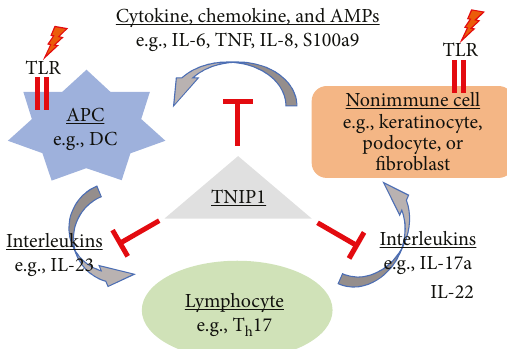
Figure 2: IL-23/Th17 axis of psoriasis. Proposed paracrine signaling with TNIP1 regulation in psoriasis where nonimmune cells are keratinocytes [111]. We would suggest that variations of this could be relevant for SLE and SSc, where the nonimmune cells are a podocyte or fi broblast, respectively. For instance, following TLR7 or 9 activation of APCs in SLE, paracrine signaling would include type I